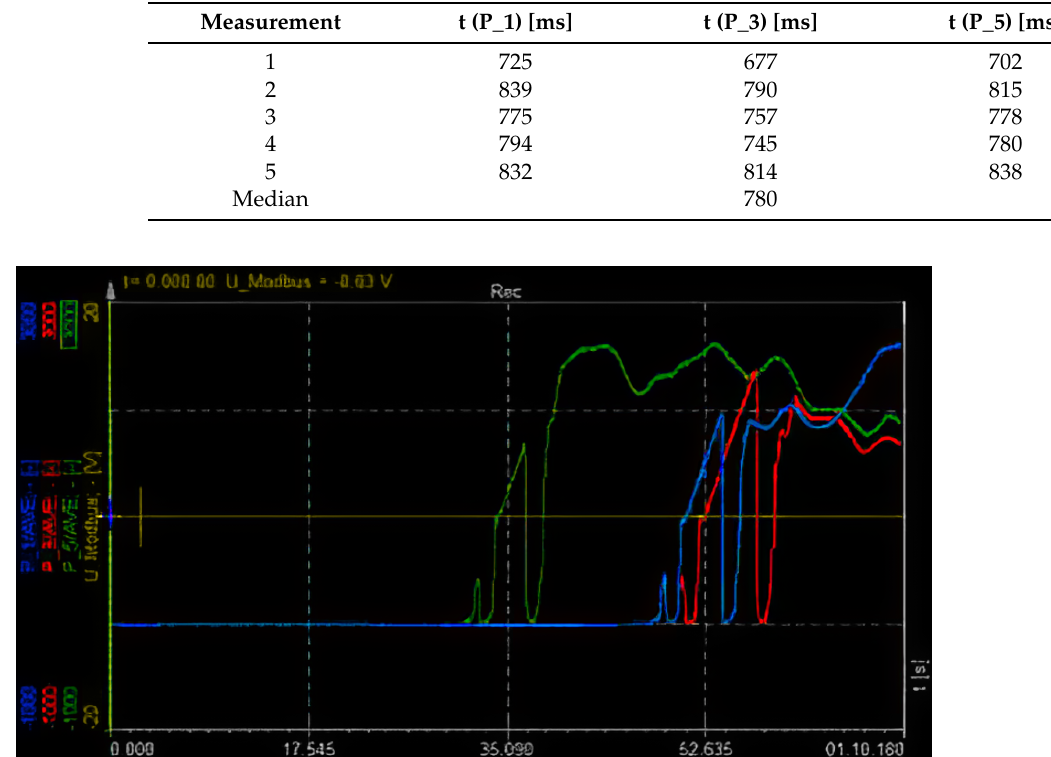
Table 2. Measurement results: shutdown.